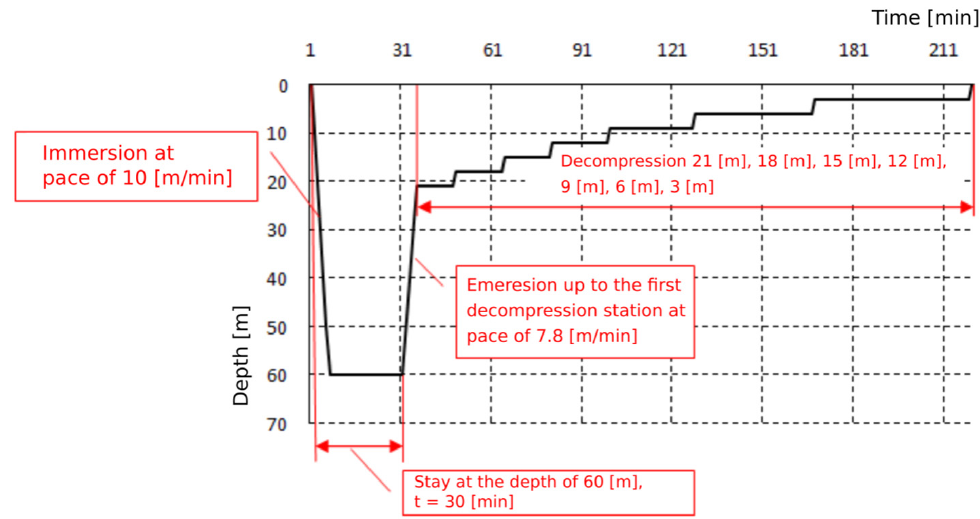
Figure 2. Pressure exposure profile 60 m/30 min.